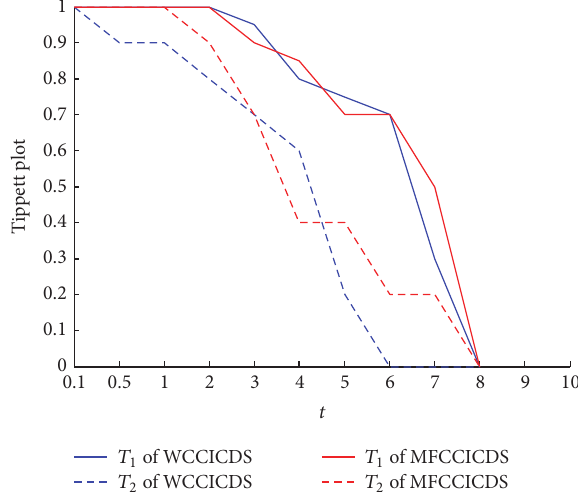
Figure 5: Tippett plot curve of the speaker recognition